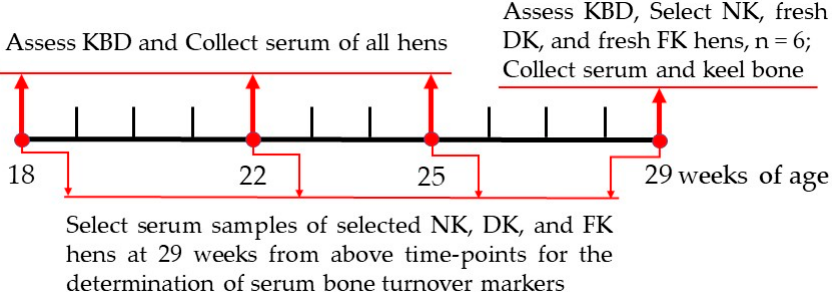
Figure 1. The experimental design, keel bone assessment, and sample collection time. NK = normal keel bone; DK = deviated keel bone; FK = fractured keel bone; KBD = keel bone damage. keel bone; DK = deviated keel bone; FK = fractured keel bone; KBD = keel bone